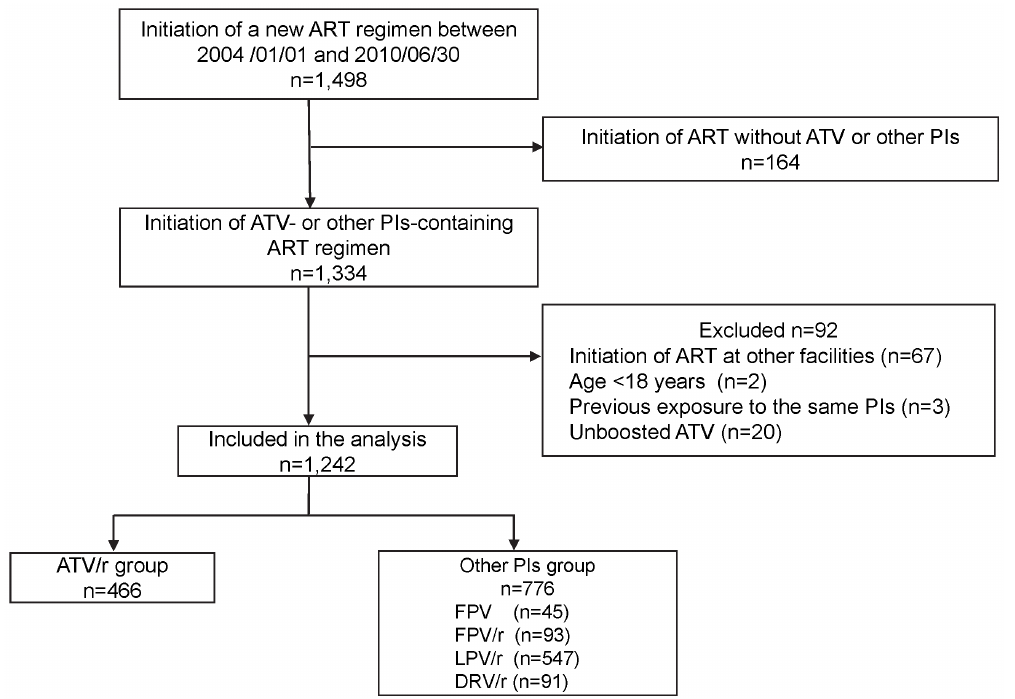
Figure 1. Flow diagram of patient selection. ART, antiretroviral treatment; ATV, atazanavir; PIs, protease inhibitors; LPV/r, lopinavir/ritonavir; ATV/r, ritonavir-boosted atazanavir; FPV, fosamprenavir; FPV/r, ritonavir-boosted fosamprenavir; DRV/r, ritonavir-boosted darunavir.